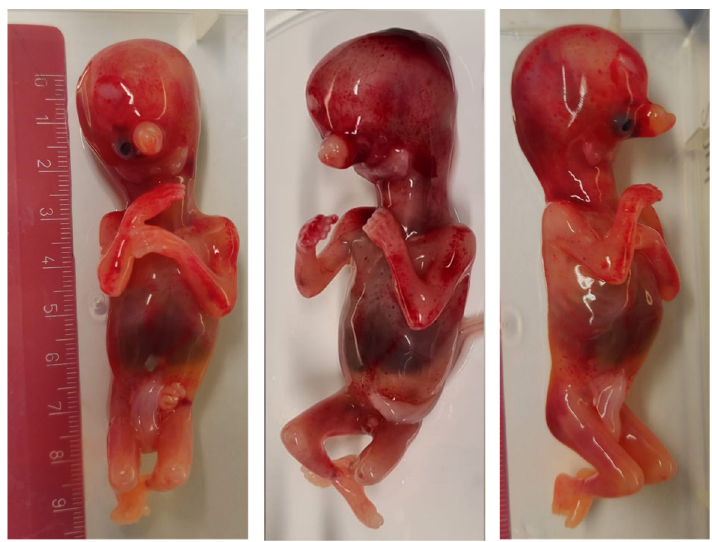
Figure 2. Front and profile of the fetus at 13 weeks after a medical abortion, showing cyclopia, agnathia, synotia and the presence of a proboscis.